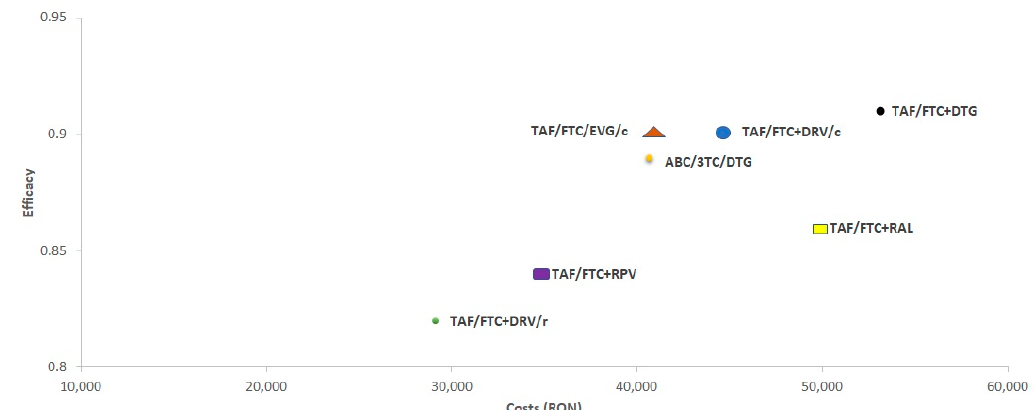
Figure 1. Illustration of efficacy scores by associated costs (RON) for cARTs included in the analysis (base-case scenario).